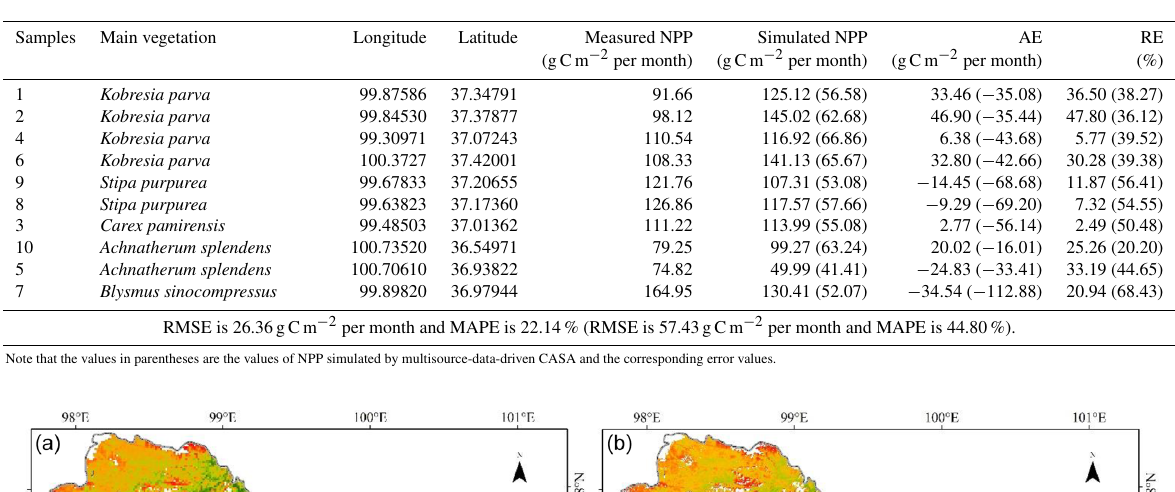
Table 4. Measured versus simulated NPP.